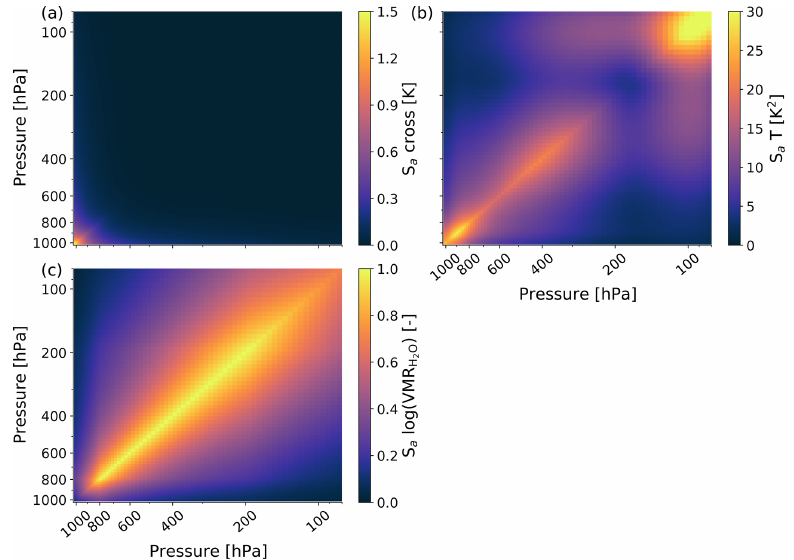
) (c) , temperature (b) and the cross-covariance matrix between water vapour and tempera- Figure 2. Covariance matrices of log ( VMR H 2 O ture (a) used for the retrieval in this study. Each of these matrices constitutes a block within the full covariance block matrix S a . Note that it is sufficient to show only one cross-covariance matrix block, since S a is block symmetric.